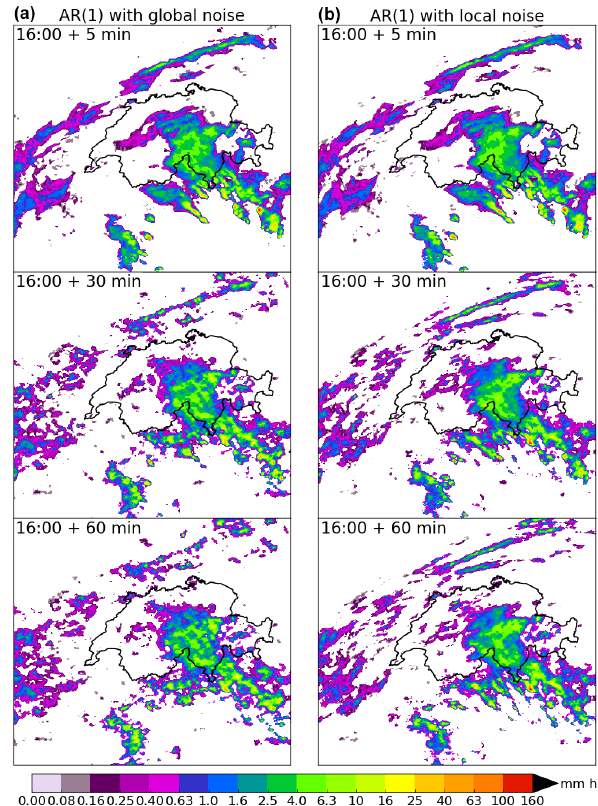
Figure 13. Example of simplified stochastic rainfall nowcasting for case study 2 (15 May 2015). Here the advection component is ne- glected and the movement of the rainfall field is assumed to be zero. Growth and decay processes are simulated stochastically using an AR(1) process with a globally (a) or locally (b) generated shock term. The lag-1 autocorrelation coefficient was set equal to 0.94. A local adjustment as in Sect. 5.4 was included at 64km resolu- tion. The national borders of Switzerland are included as spatial reference (black contour). Both simulations share the same random